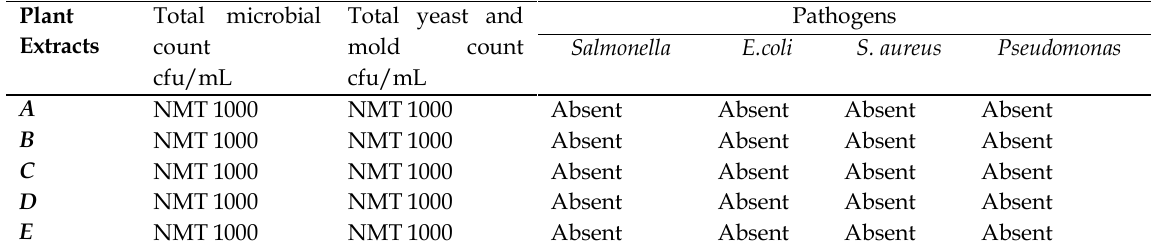
Table 4 . Microbiological analysis of N. arbor-tristis, H. salicifolia, O. tenuiflorum and R. indica . NMT=Not More Than, A=N. arbor-tristis, B=H. salicifolia, C=O. tenuiflorum, D=R. indica, E=Combined herb